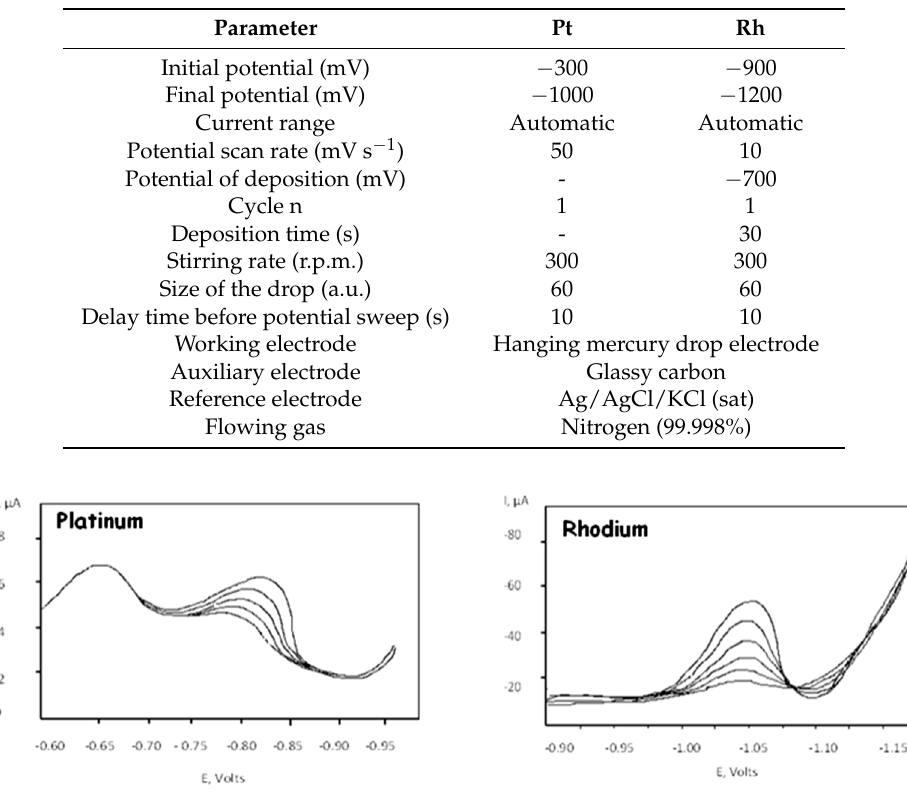
Figure 1. Voltammetric curves for platinum and rhodium .